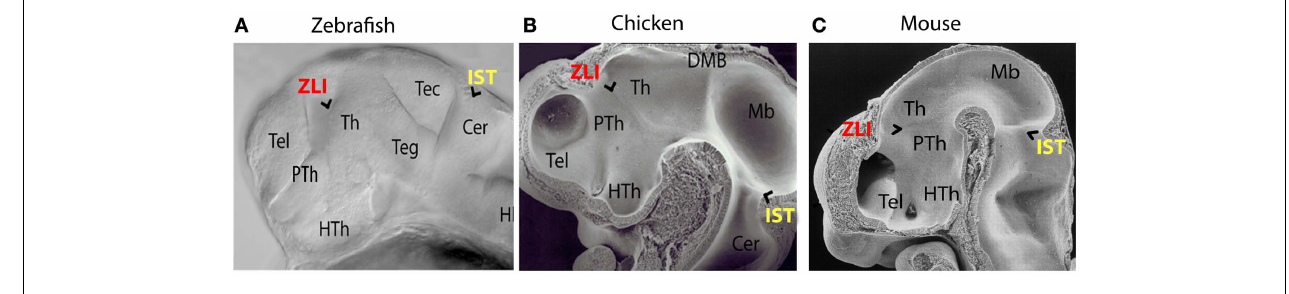
whereas the isthmus rhombencephali (IST) marks the constriction between midbrain and hindbrain.Th, thalamus; PTh, prethalamus; HTh, Hypothalamus;Tel,Telencephalon;Teg, tegmentum;Tec, tectum; Cer, cerebellum; Mb, midbrain; DMB, diencephalic-mesencephalic boundary; Hi, hindbrain.